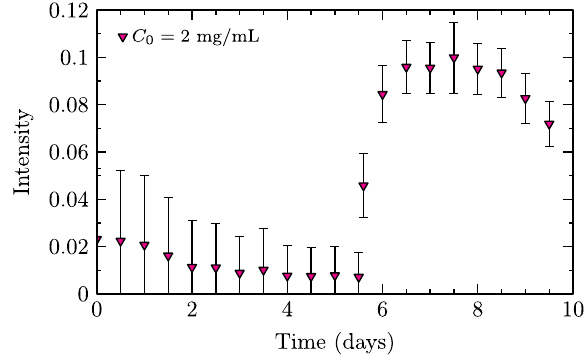
Fig. 5 Intensity of scattered light versus time for the 2 mg/mL native insulin case with seeding by insulin fi brils at 5.6 days. ±1 standard deviation error bars represent measurement